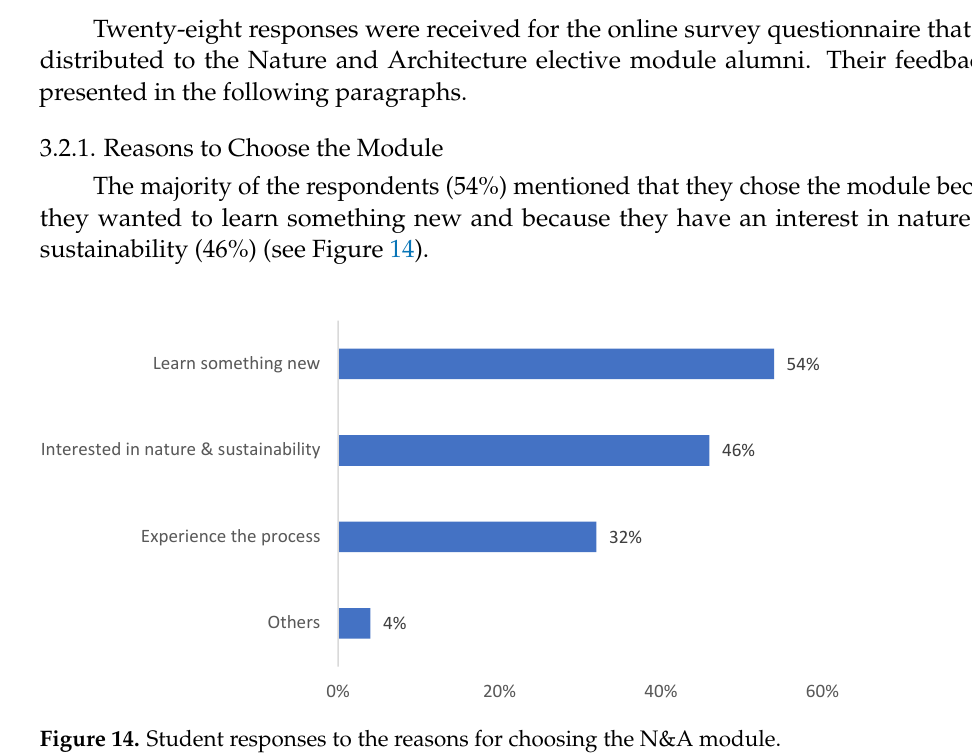
Figure 13. Classification of student projects by the type of model organism, type of biomimicry, themes, and biomimicry application at different levels.